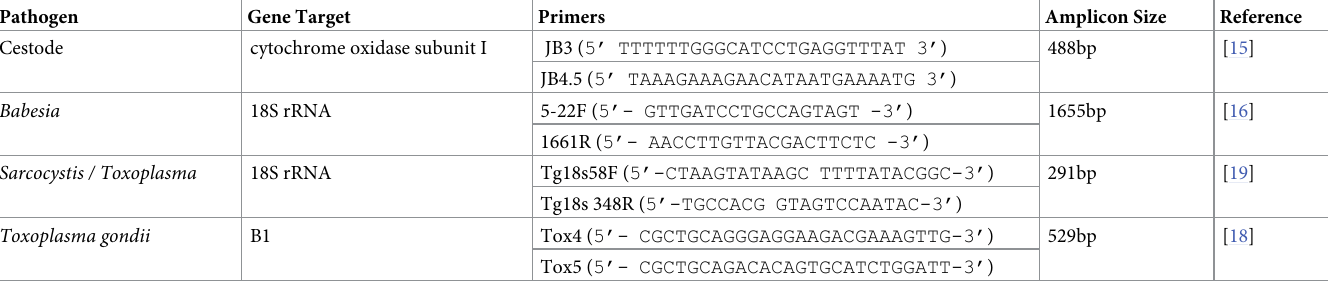
Table 1. Polymerase chain reaction protocols used for detection of selected pathogens in muskrats ( Ondatra zibethicus